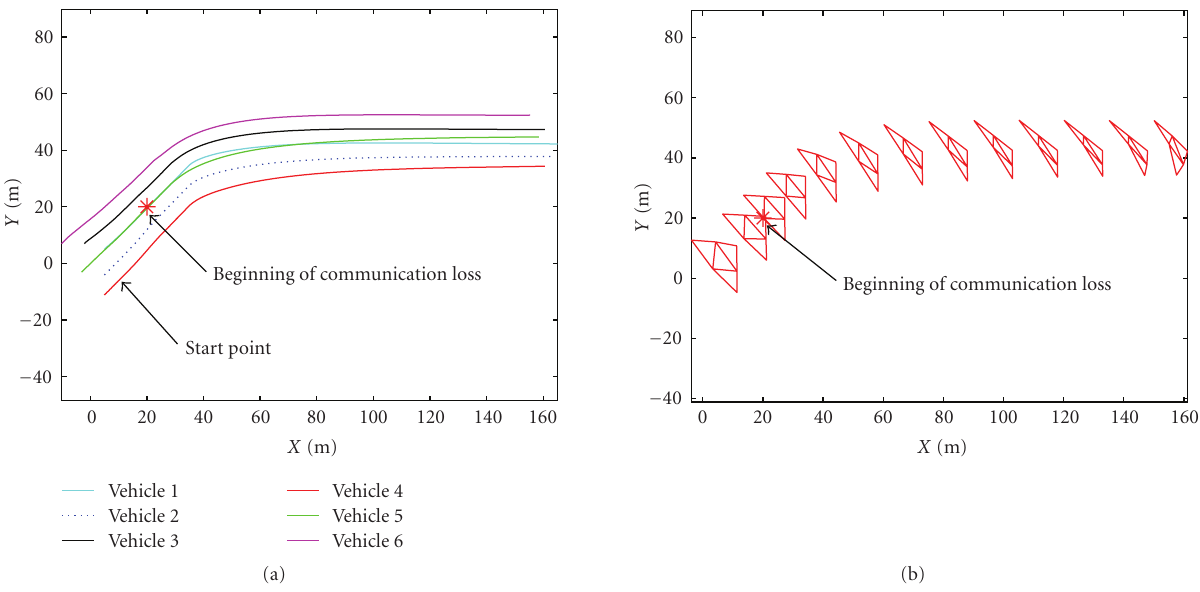
Figure 9: Trajectory (a) and formation snapshot (b) of six vehicles in triangular formations when Algorithm 1 is